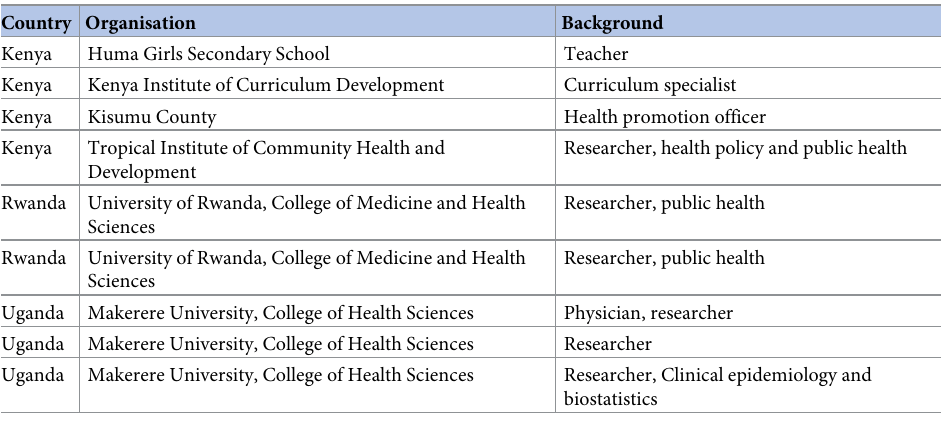
Table 2. Judges for the initial prioritisation *